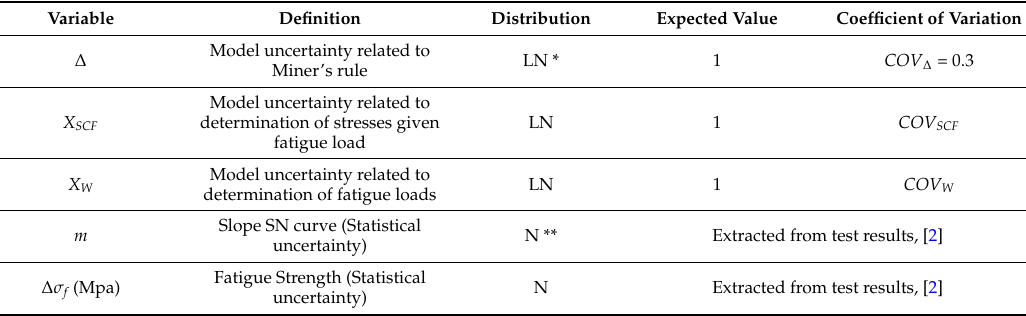
Table 3. Stochastic model of fatigue strength based on SN curves. Variable Definition Distribution Expected Value Coefficient of Variation Model uncertainty related to COV ∆ = 0.3 Miner’s rule LN * 1 Model uncertainty related to determination of stresses given LN 1 COV SCF fatigue load Model uncertainty related to COV W determination of fatigue loads LN 1 Slope SN curve (Statistical uncertainty) N ** Extracted from test results, [2] Extracted from test results, [2]